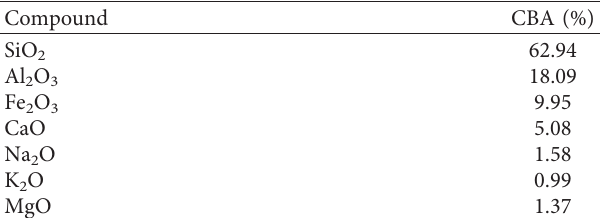
Table 2: Chemical composition of the